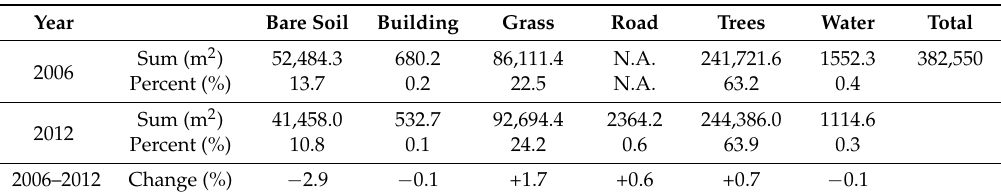
Table 4. Quantification of relative land-cover change (LCC) per land-cover class. The total surface area is 382,550 m 2 .